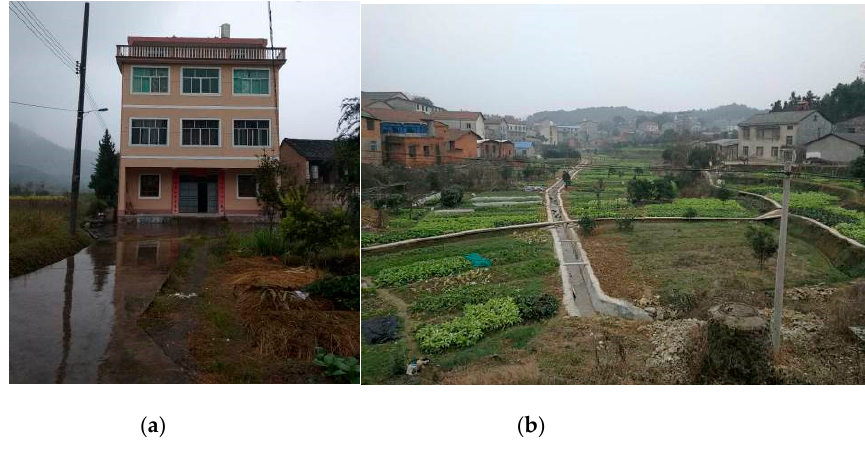
Figure 9. ( a ) Typical brick–concrete and ( b ) brick–wood buildings in the study area.